Question: What form of chart is displayed?
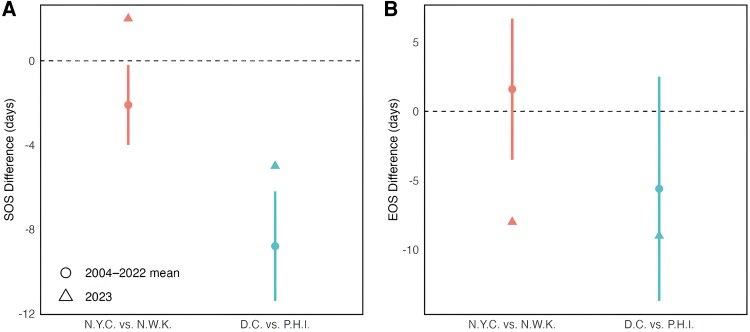
Answer: bar